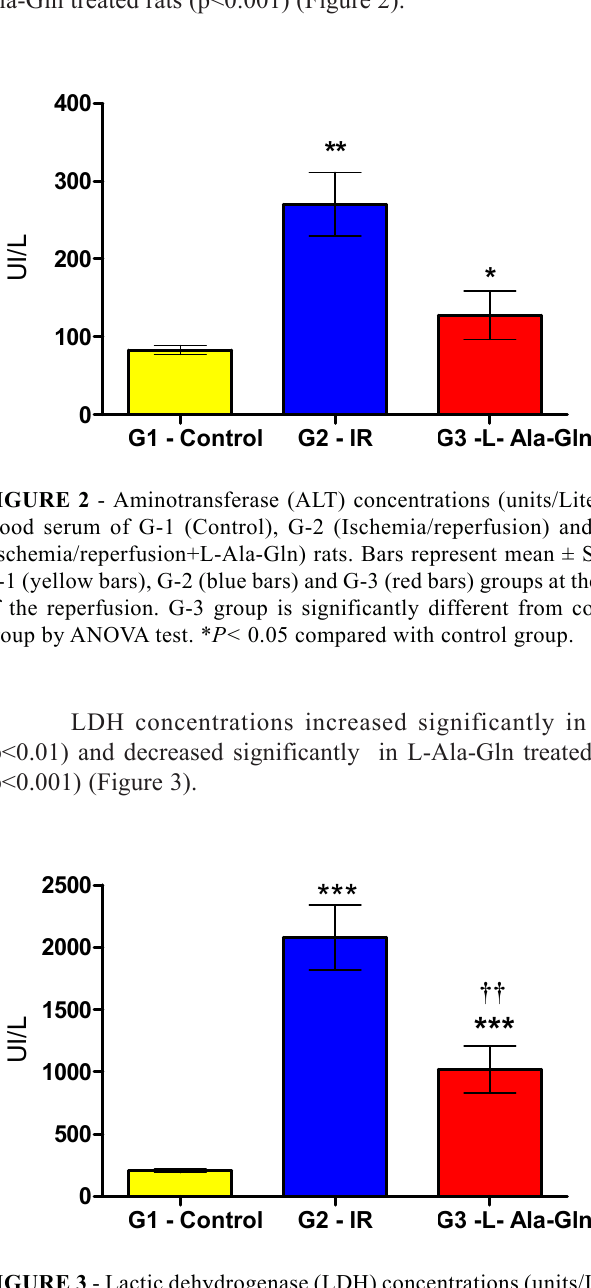
FIGURE 3 - Lactic dehydrogenase (LDH) concentrations (units/Liter) in blood serum of G-1 (Control), G-2 (Ischemia/reperfusion) and G-3 (Ischemia/reperfusion+L-Ala-Gln) rats. Bars represent mean ± SD of G-1 (yellow bars), G-2 (blue bars) and G-3 (red bars) groups at the end of the reperfusion. G-3 group is significantly different from G-2 ( P <0.01) and control group ( P <0.001). G-2 group is significantly different from control group ( P< 0.001). ANOVA